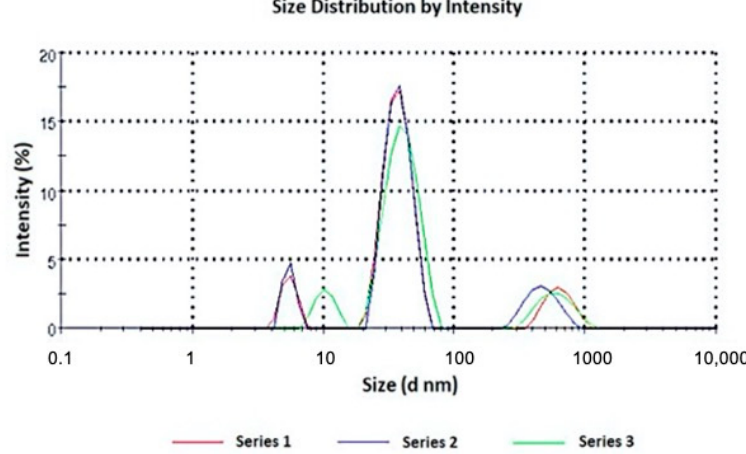
Figure 2. Size distribution of HM10 loaded in F127 micelles, in triplicate.